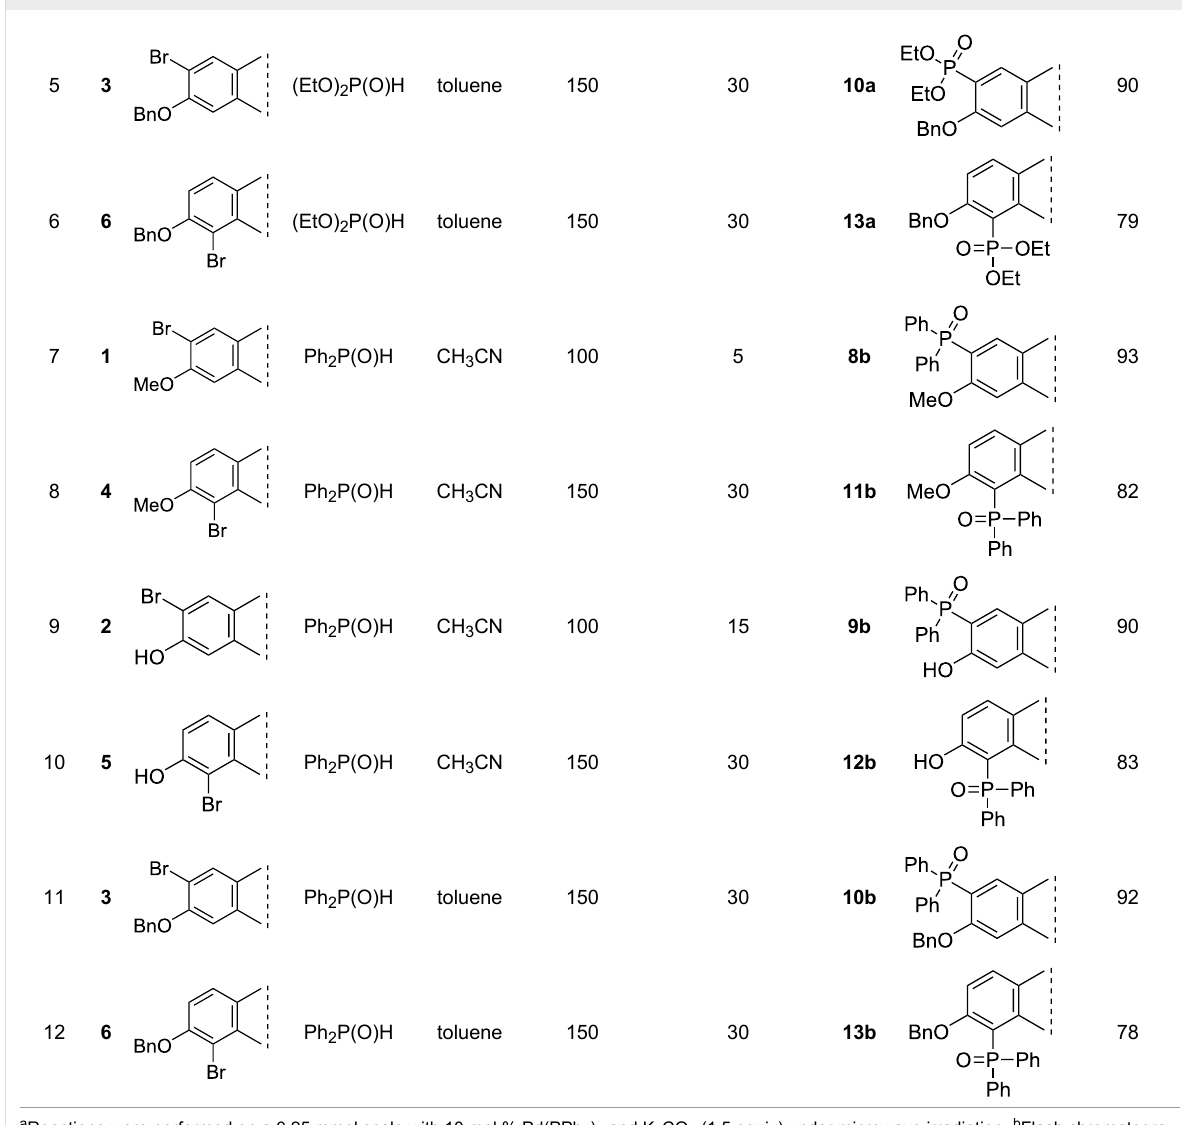
Table 2: Scope of the reaction a of 2- or 4-bromo-13 α -estrones 1 – 6 with diethyl phosphite ( 7a ) or diphenylphosphine oxide ( 7b ).